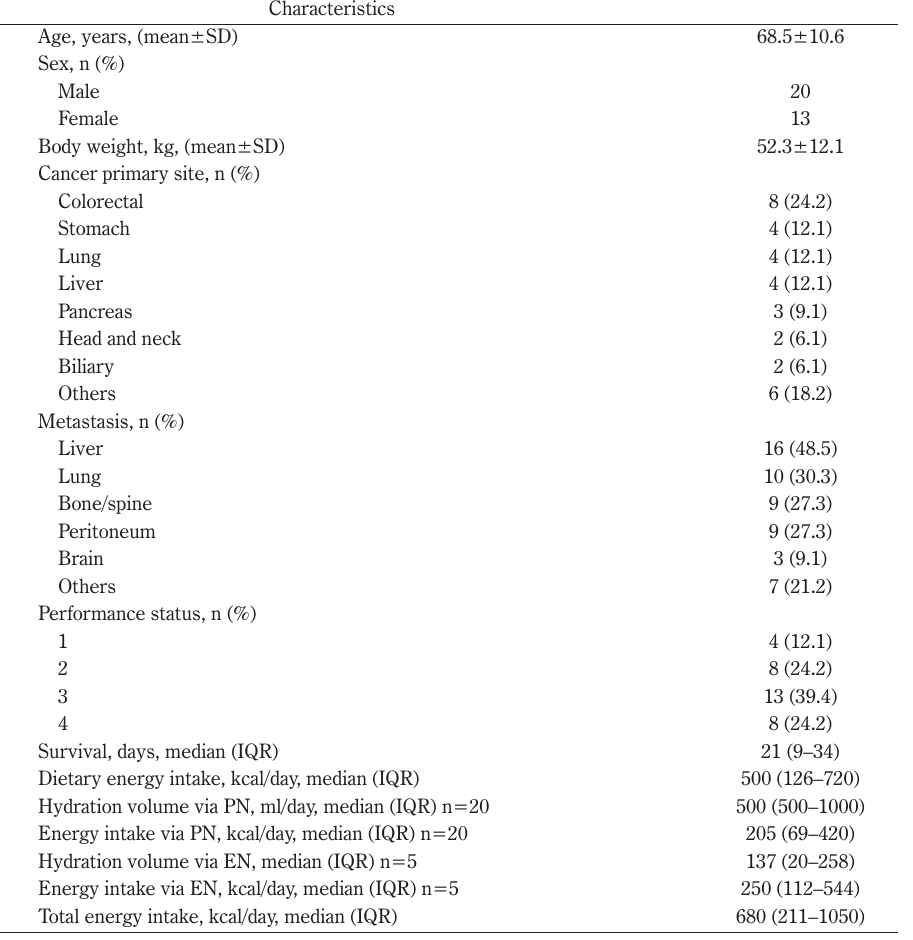
Table 1 Patients’ characteristics